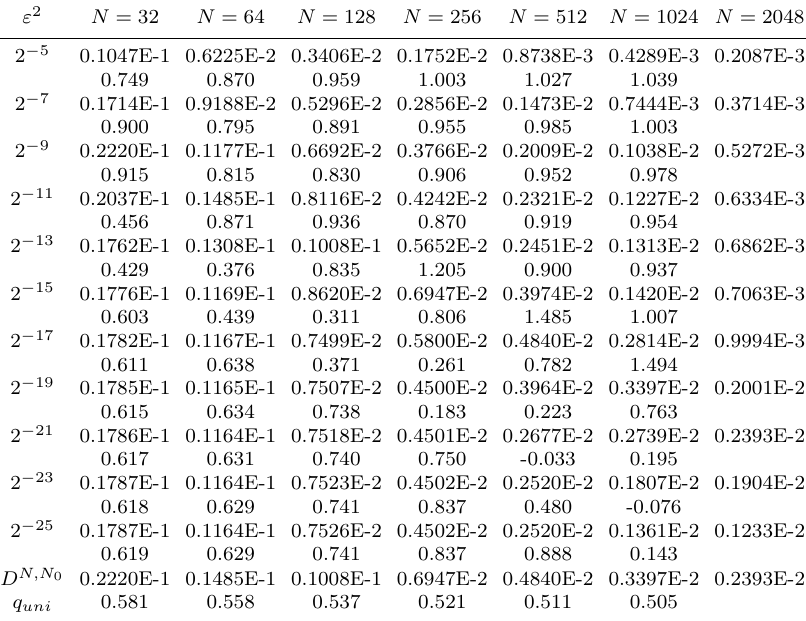
Table 4. Maximum errors and ε -uniform orders of convergence on the Shishkin mesh for problem (4.1), (4.2) with m = 5 ε 2 N =